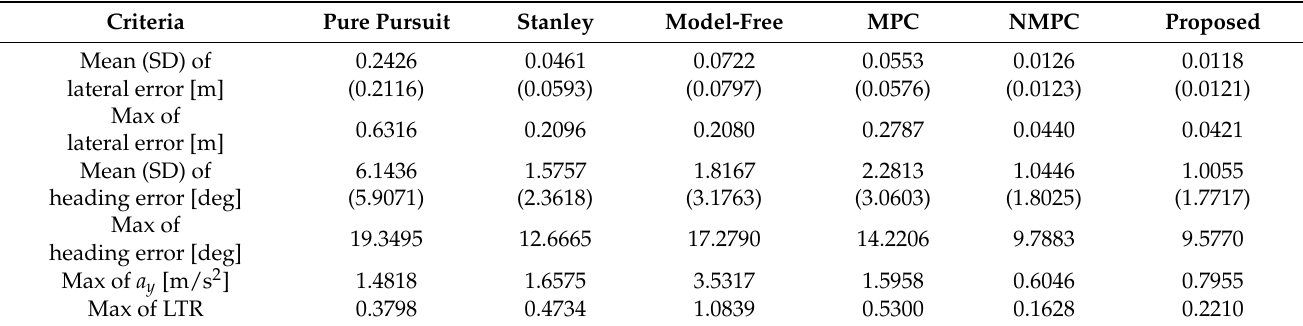
Figure 7. Simulation results of each algorithm: ( a ) lateral error, ( b ) heading angle error, ( c ) articulation angle, ( d ) speed of the front body, ( e ) speed of the rear body, ( f ) yaw rate of the front body, ( g ) yaw rate of the rear body, ( h ) lateral acceleration of the front body, ( i ) lateral acceleration of the rear body, ( j ) LTR of the front body, and ( k ) LTR of the rear body. Table 2. Performance comparison between